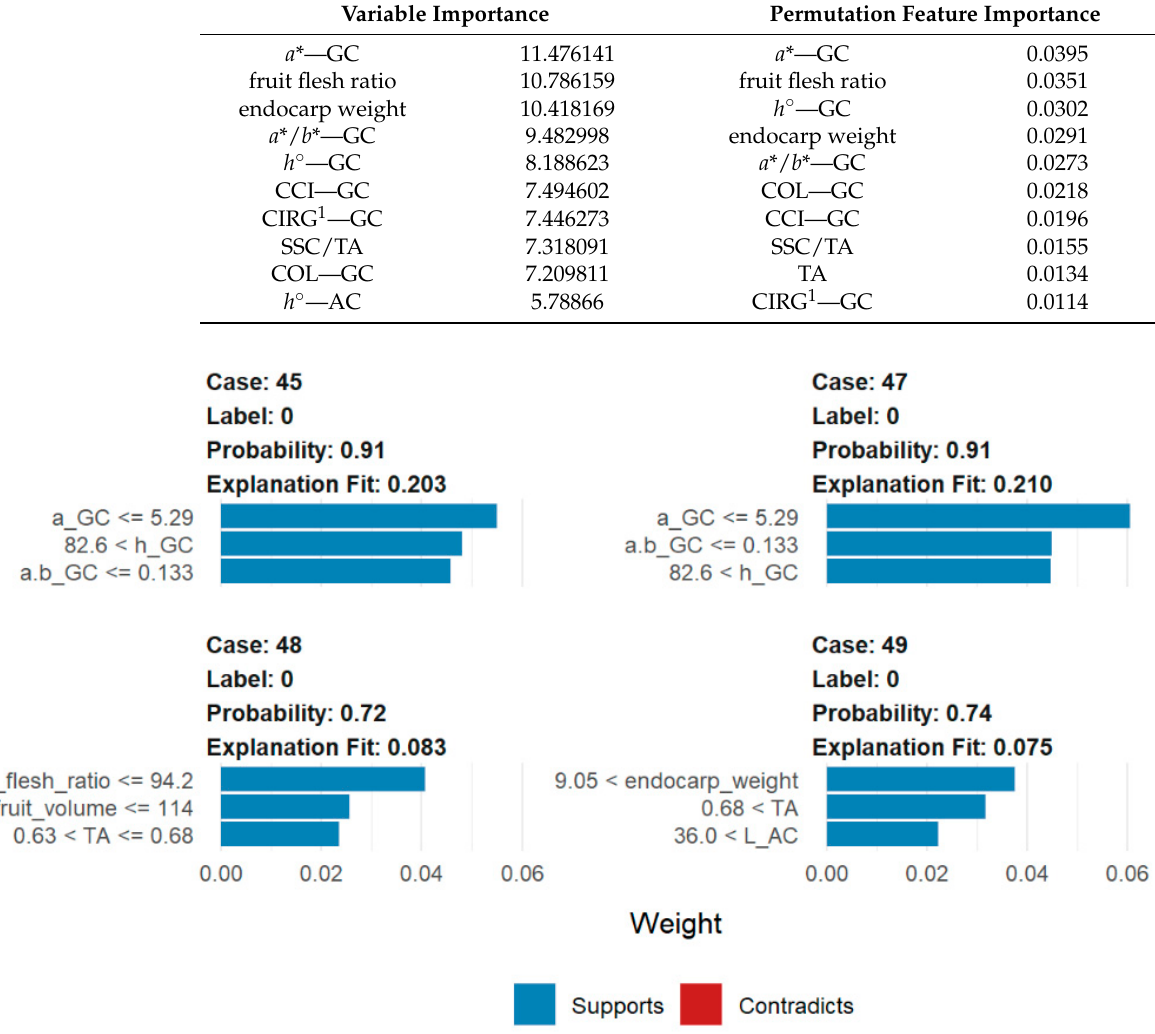
Table 4. Top 10 most contributing variables in the SMOTE balanced Model B dataset.